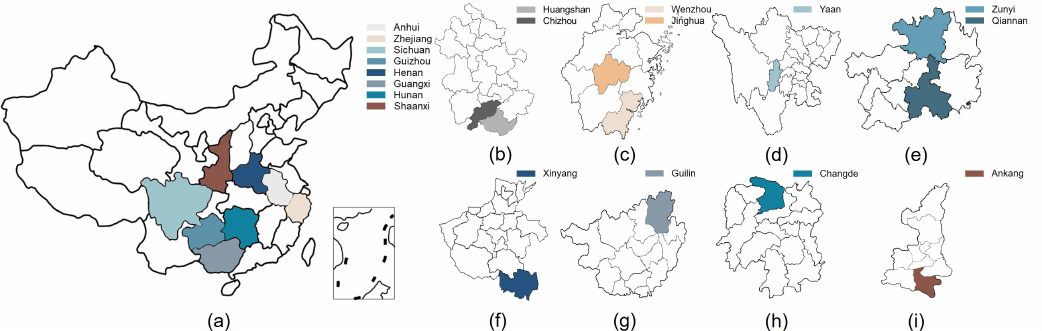
Figure 1. Geographical information of the tea-producing areas. ( a ) Location of the eight provinces (Anhui, Zhejiang, Sichuan, Guizhou, Henan, Guangxi, Hunan, and Shaanxi) in China; ( b ) Huangshan City and Chizhou City in Anhui Province; ( c ) Wenzhou City and Jinghua City in Zhejiang Province; ( d ) Yaan City in Sichuan Province; ( e ) Zunyi City and Qiannan Prefecture in Guizhou Province; ( f ) Xinyang City in Henan Province; ( g ) Guilin City in Guangxi Province; ( h ) Changde City in Hunan Province; ( i ) Ankang City in Shaanxi